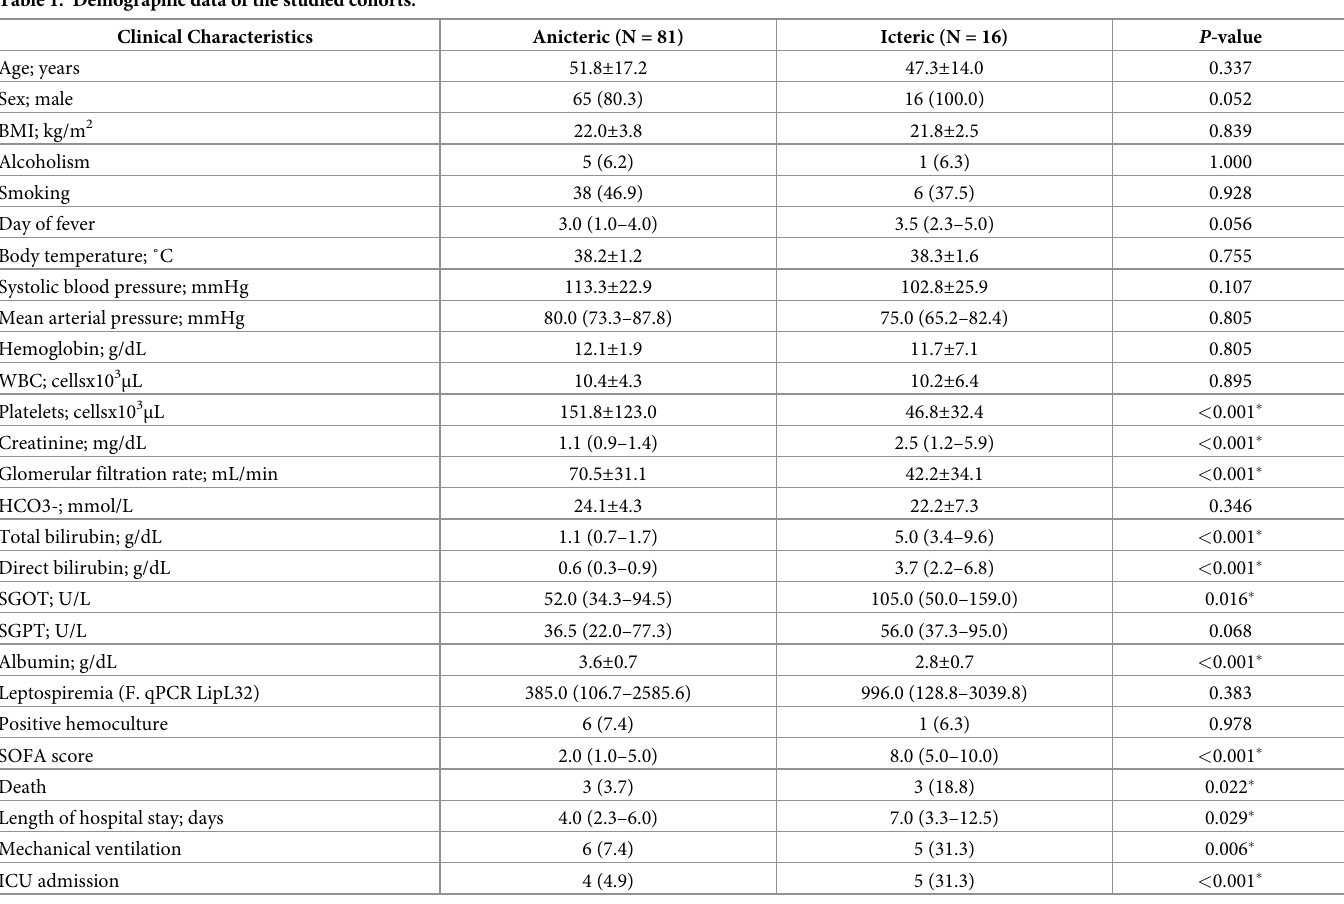
Table 1. Demographic data of the studied cohorts. Clinical